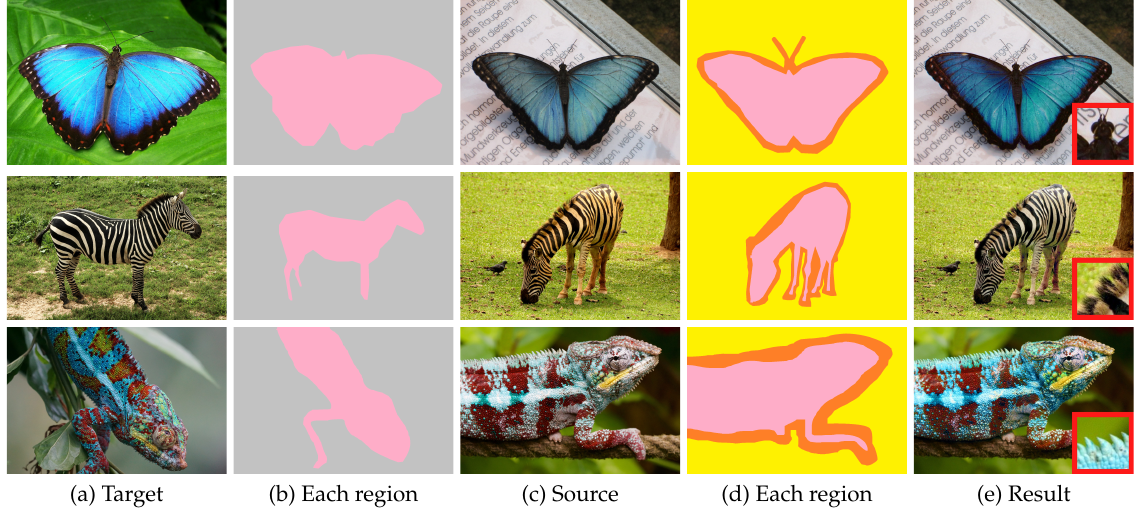
Figure 15. Semi-automatic color correction. ( a ) target; ( b ) each region in the target image; ( c ) source; ( d ) each region in source image, and ( e ) results. Colors in ( b , d ) indicate each region as Figure 3. The source and target images are available at https://pixabay.com (accessed on 3 August 2017).